Question: What type of chart is this?
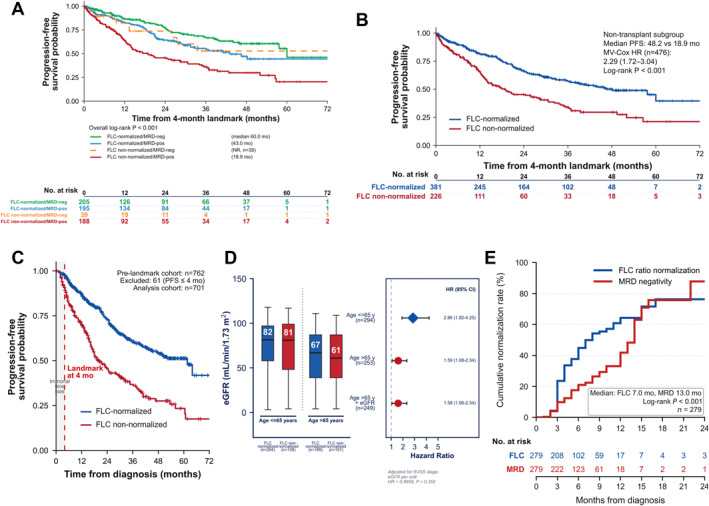
Answer: survival